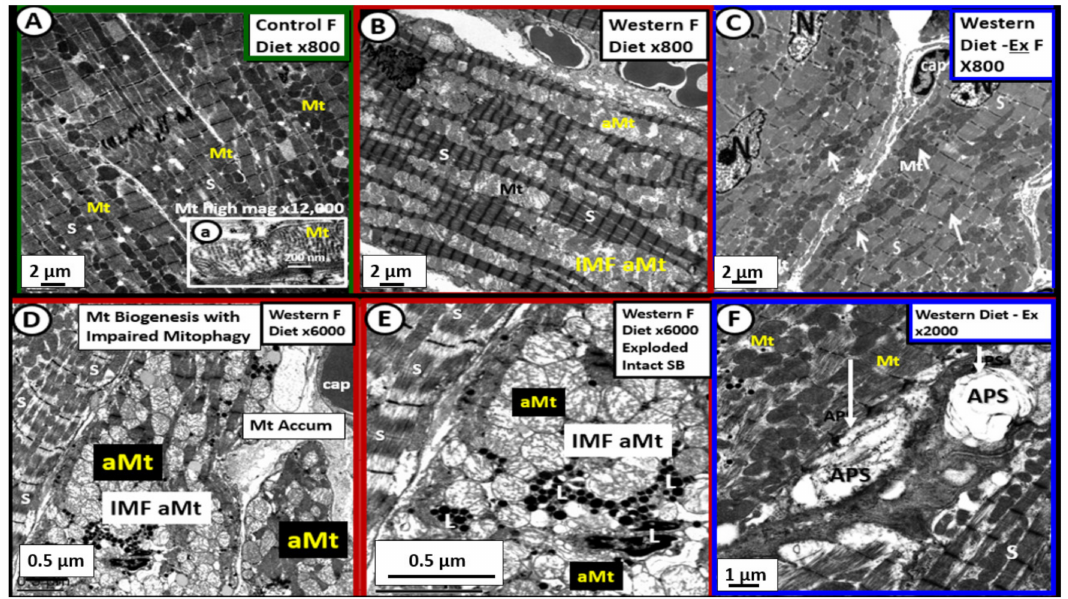
Figure 6. Mitochondrial biogenesis and the accumulation of aberrant mitochondria (aMt) due to impaired mitophagy in the left ventricle of Western diet-induced obesity female mice at 20-weeks of age. Panel A illustrates the normal morphology of the alternating row of sarcomeres with usually a single row of electron-dense intermyofibrillar mitochondria (IMF Mt). Note that insert ( a ) depicts normal crista morphology. Panel B depicts the moderate expansion of the IMF aberrant Mt (aMt) in Western models with hypertrophic Mt and increased hyperlucency as compared to the electron-dense mitochondria in panel A . Panel C reveals the protective role of enhanced exercise (Ex) via increased heme oxygenase-1 on Mt remodeling. Panels D and E depict marked IMF Mt expansion (biogenesis) with an accumulation of aMt that are hyperlucent with attenuation and loss of crista and a loss of the electron-dense Mt matrix in obese Western models. Note that panel E is an exploded view of the IMF aMt in panel D to better demonstrate the abnormalities of the IMF aMt. Panel F is interesting as it depicts areas of mitophagy with 2 different autophagosomes (APS white arrows) amongst areas that appeared more like the control models in panel A and in the exercise (Ex) model ( panel C ), which suggests that exercise may improve mitophagy and limit aMt. These modified images were provided with permission by CC 4.0 [25]. Magnifications vary and scale bars are located in the lower left-hand and magnification in the upper right-hand side of each image. Cap = capillary; N =